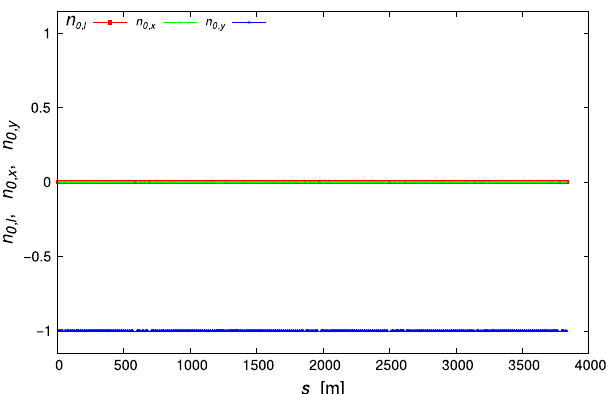
FIG. 15. Spin ⃗ n 0 vector around Yellow ring and tilt angle. Regular polarized proton injection optics, snake field maps, and orbit bumps in place, helix currents as in Fig. 15. The spin tilt to vertical reaches 3.5° in the